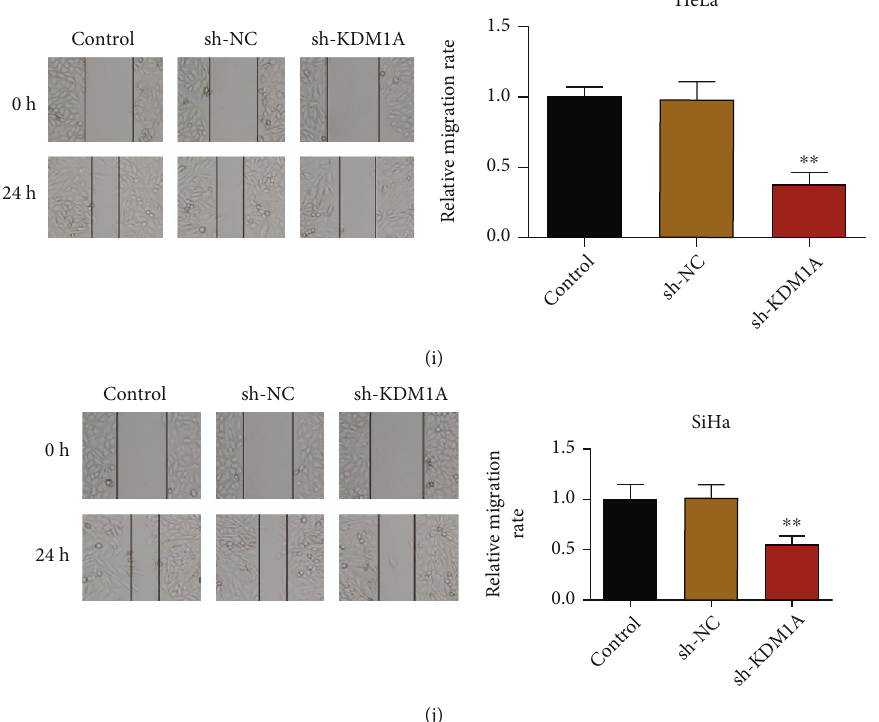
Figure 2: Knockdown of KDM1A contributes to the suppressed cell proliferation and migration of cervical cancer cells. (a) mRNA expression level of KDM1A in HeLa cells after KDM1A knockdown was determined by qRT-PCR; (b) protein expression level of KDM1A in HeLa cells after KDM1A knockdown was determined by western blot; (c) mRNA expression level of KDM1A in SiHa cells after KDM1A knockdown was determined by qRT-PCR; (d) protein expression level of KDM1A in SiHa cells after KDM1A knockdown was determined by western blot; (e) CCK8 assay was applied to assess the e ff ect of KDM1A knockdown on proliferation of HeLa cells; (f) CCK8 assay was applied to assess the e ff ect of KDM1A knockdown on proliferation of SiHa cells; (h, h) cell clone formation assay was used to assess the e ff ect of KDM1A knockdown on cell clones in HeLa cells and SiHa cells; (i, j) wound healing assay analyzed the e ff ect of KDM1A knockdown on cell migration in HeLa and SiHa cells. ∗ p < 0 : 05 and ∗∗ p < 0 : 01 , compared with the control